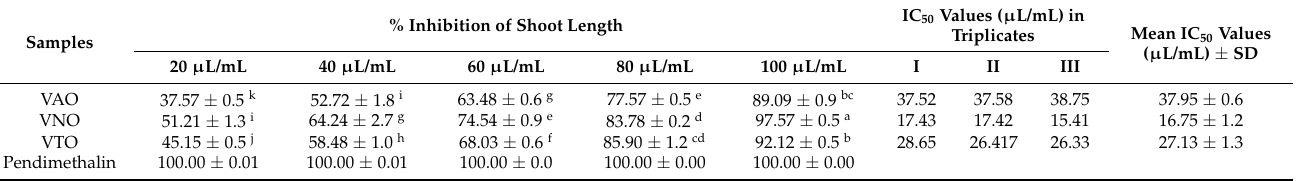
Table 4. Mean % inhibition and IC 50 values for shoot length inhibition by tested essential